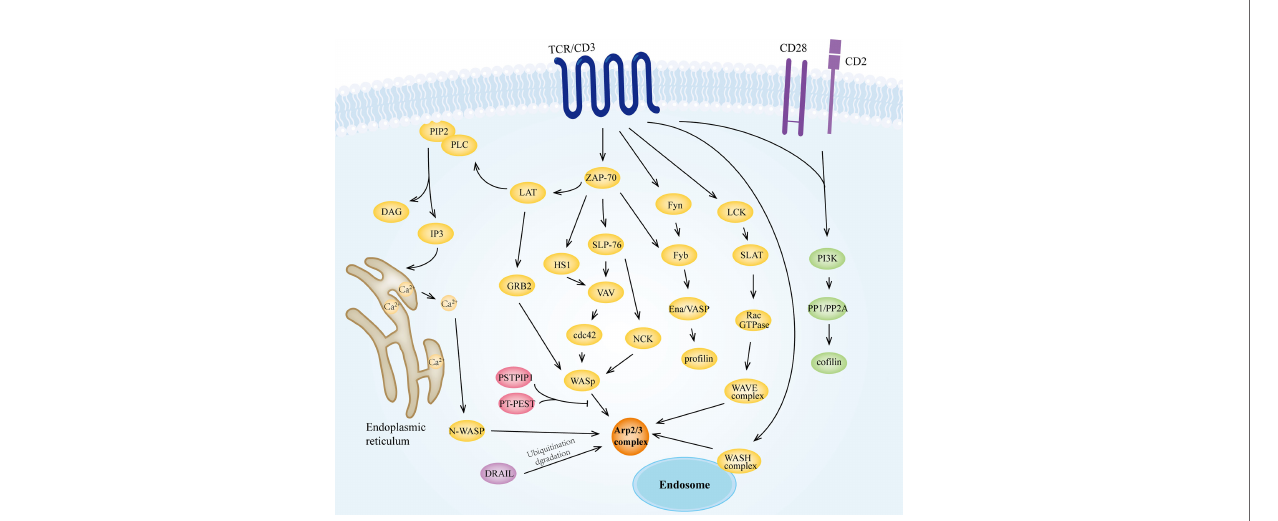
FIGURE 5 | The Arp2/3 complex is involved in TCR signaling. Upon receiving signals from MHC molecules, TCR/CD3 can transmit stimuli to the Arp2/3 complex via tyrosine kinases such as Fyn, LCK, and ZAP-70. In this process, WASp family proteins play an important mediating role as direct activators of the Arp2/3 complex. The activated Arp2/3 complex has the ability to promote branched fi lament polymerization, which together with other T cell signaling-induced activation of actin regulators (e.g., co fi lin and pro fi lin) modulates the actin cytoskeleton, which is important for the biological activities of T cells, especially for IS